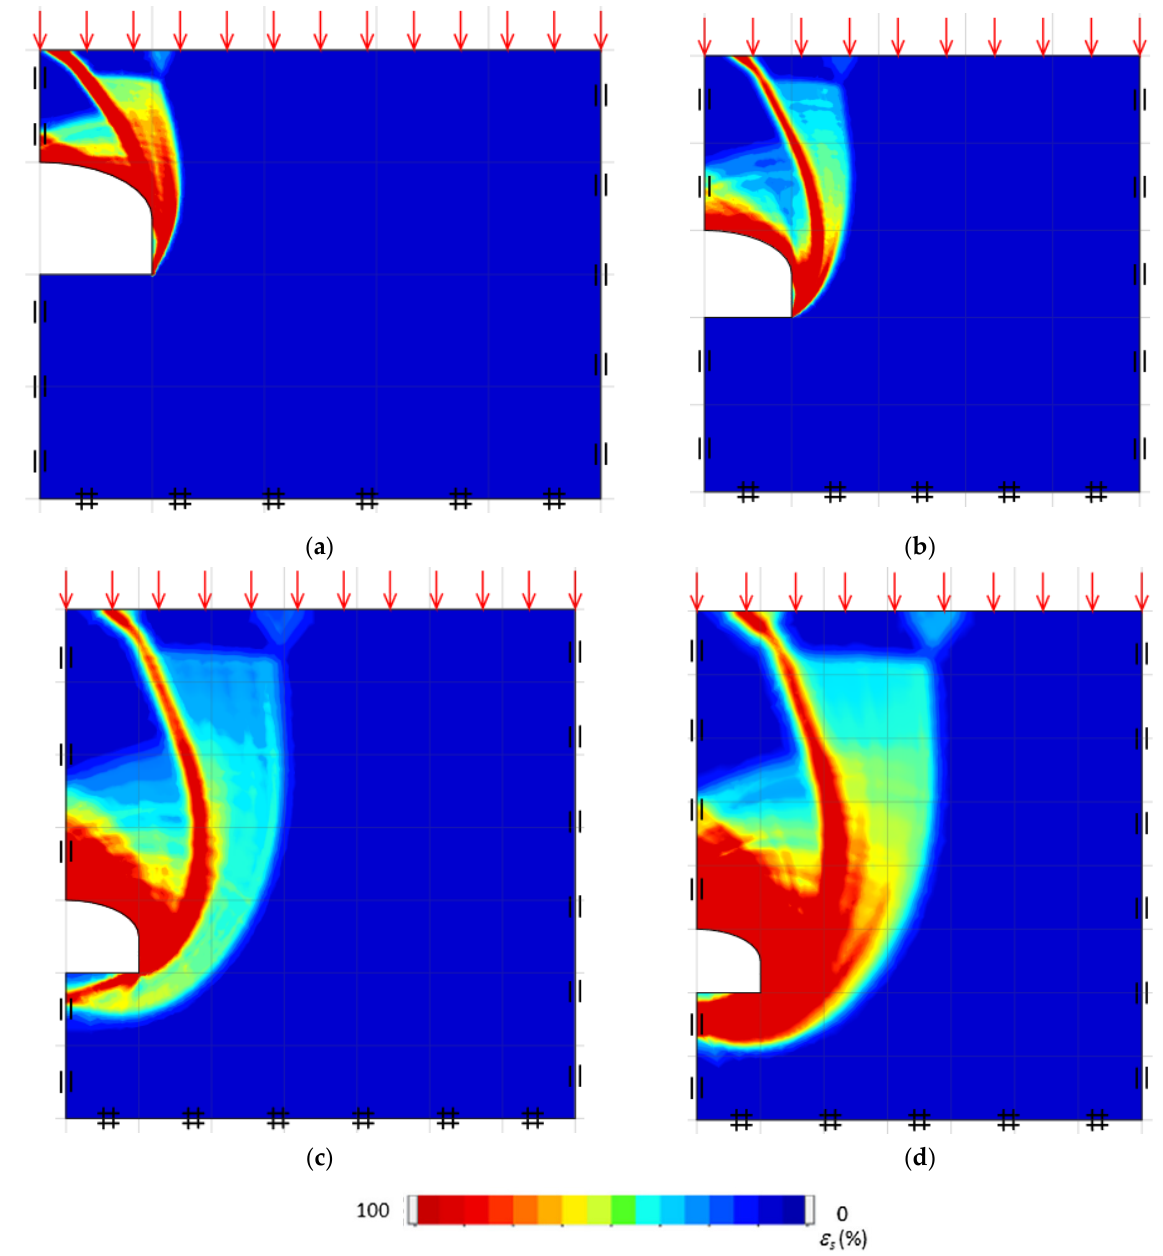
Figure 15. Shear dissipations of unlined horseshoe tunnel in rock mass with B / D = 2 for the cases of C / D : ( a ) 1, ( b ) 2, ( c ) 4 and ( d ) 5 ( σ ci / γ D = 1000, GSI = 80 and m i = 20).